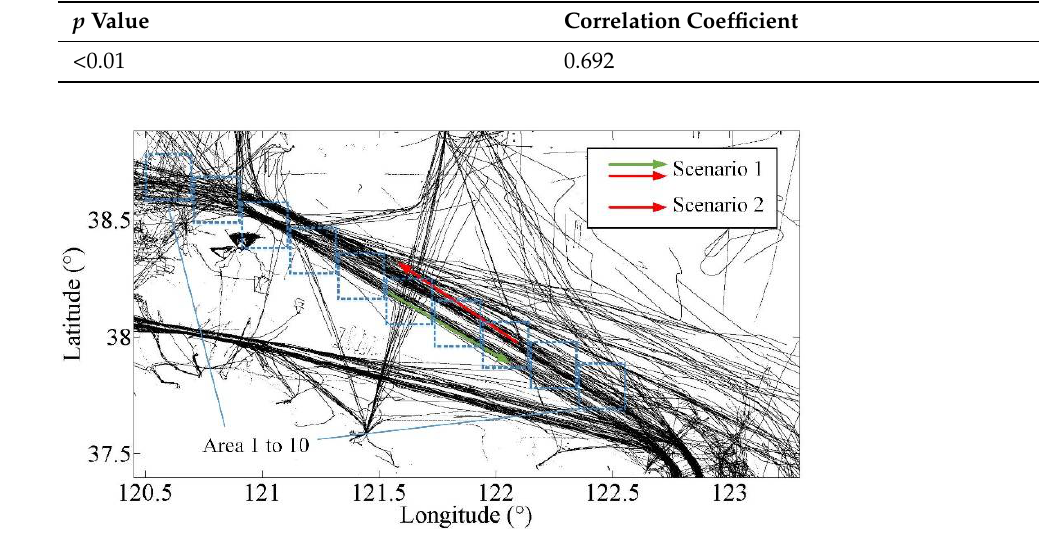
Table 5. Pearson correlation analysis between C sp and SD for 24 time nodes.